Question: What visual encoding does this figure use to show its data?
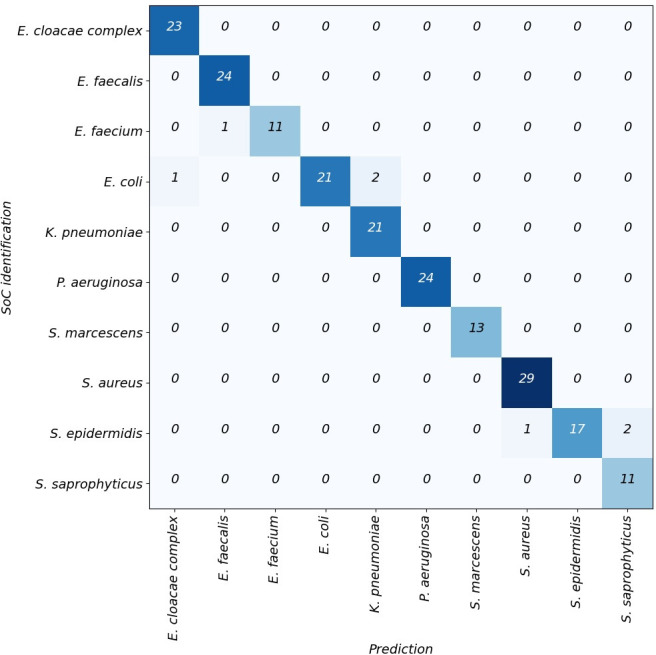
Answer: heatmap